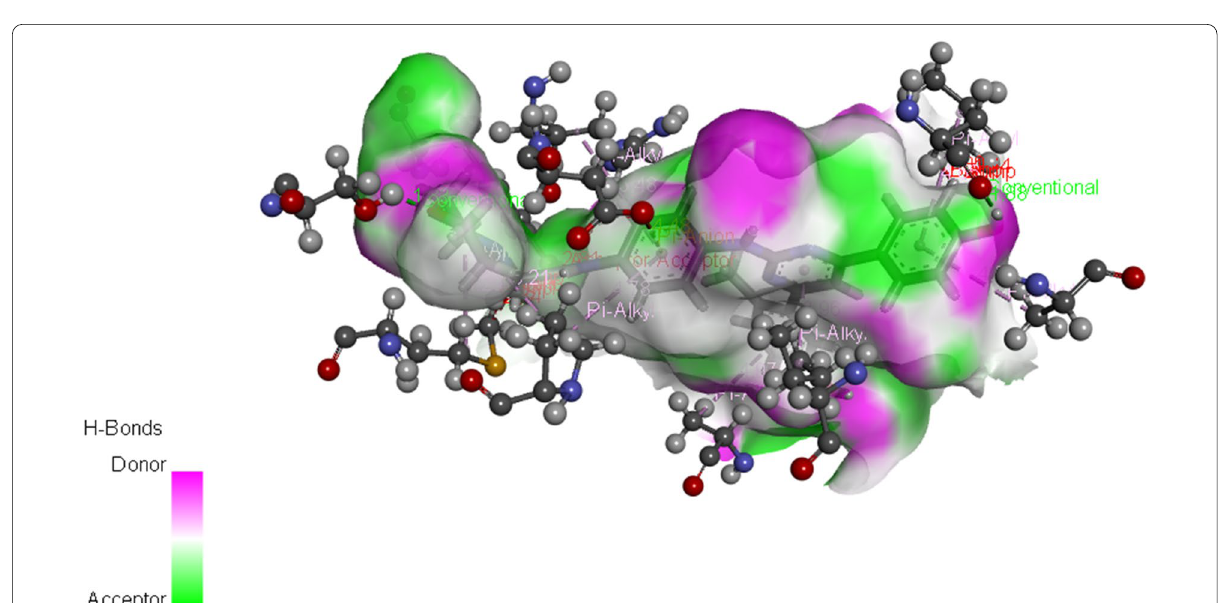
Fig. 8 3D structure of the designed compound 1 interactions with VEGFR-2